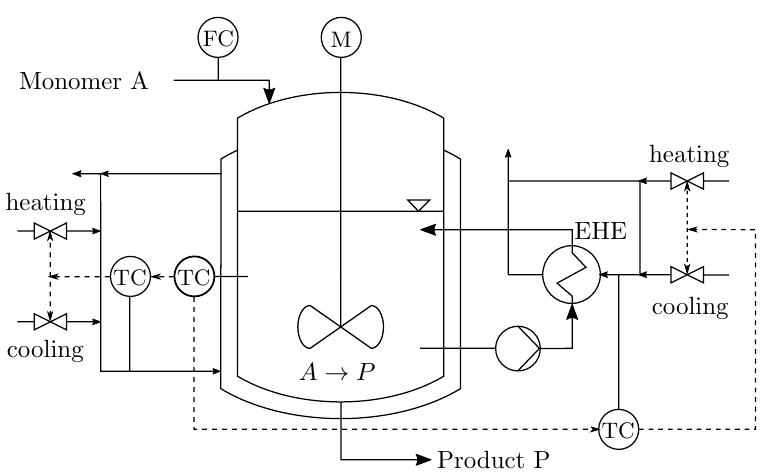
1 Figure 13. Process flow diagram of the industrial polymerization semi-batch reactor. Table 6. Case study 2: Bounds on the control